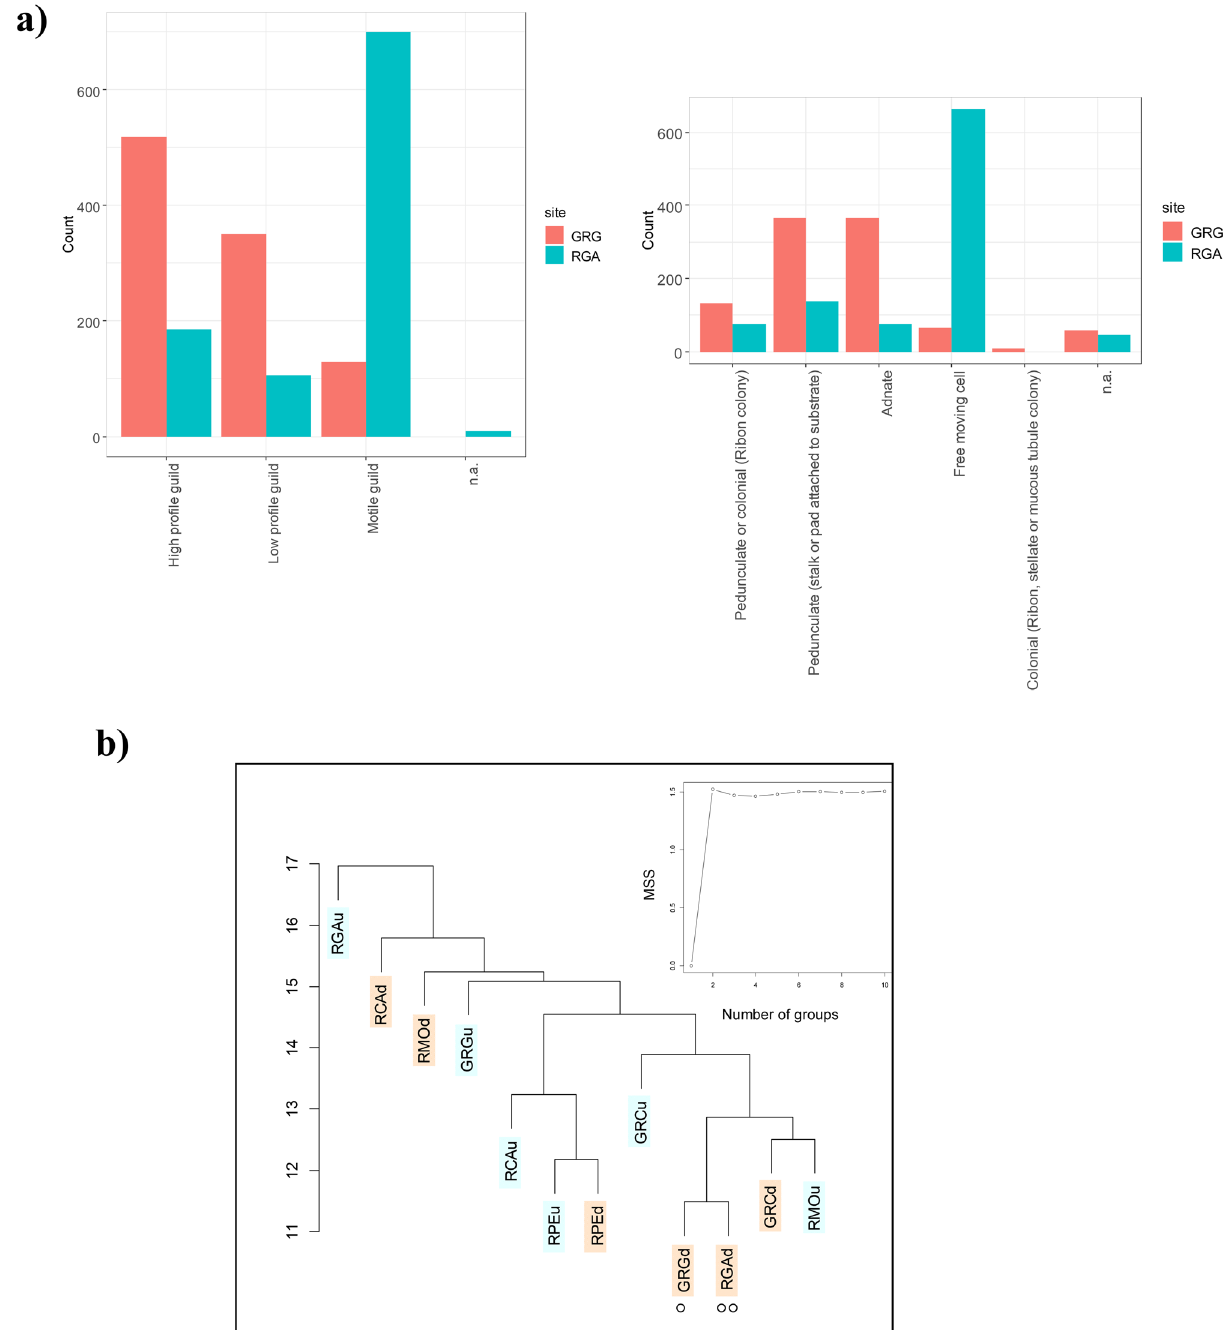
Figure 2. ( a ) Diatom species repartition in the two downstream stations (GRG and RGA) according to life form or guilds (relative abundance), ( b ) results of agglomerative hierarchical clustering of stations on the basis of their diatom assemblages, u: upstream (blue) and d: downstream (pink). The inset shows the Mean Split Silhouette (MSS) criterion for identification of optimal number of groups. ° and °° are respectively the less contaminated and the most contaminated stations. For abbreviations, see Table